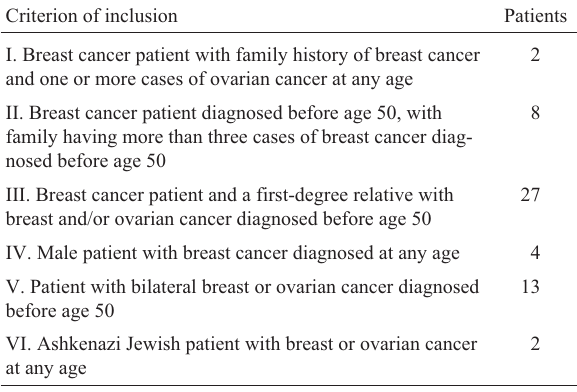
Table 1 - Number of patients included in each selection criterion. A total of 47 unrelated patients were selected, with some of them fitting more than one criterion 1 . Criterion of